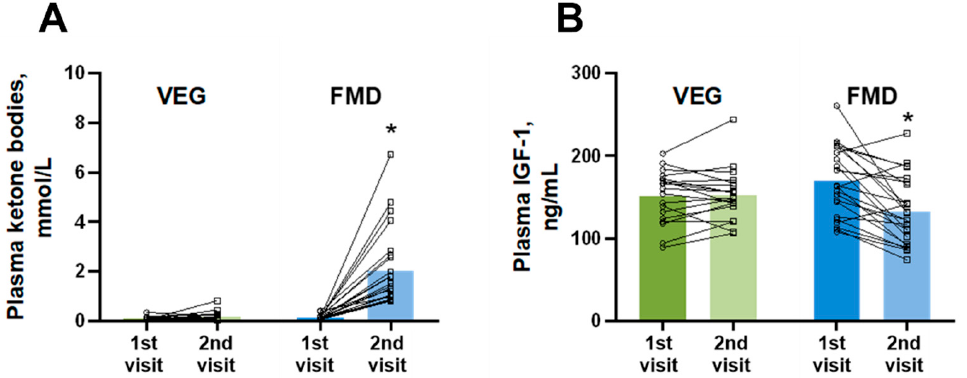
Figure 3. Changes in the levels of plasma ketone bodies ( A ) and insulin-like growth factor-1 (IGF-1) ( B ) induced by 5 days of the regular diet supplemented with additional vegetables (VEG) and fasting-mimicking diet (FMD). The results are presented as the mean and independent values of 19 volunteers in the VEG group and 24 volunteers in the FMD group. * Indicates a significant difference from the respective group at the 1st visit (Wilcoxon matched-pairs test), p < 0.05.